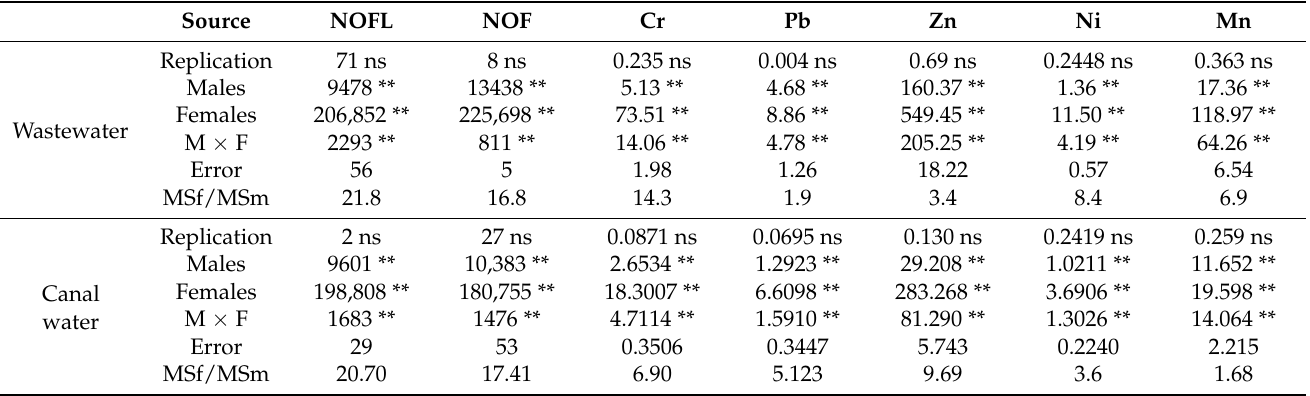
Table 1. Analysis of variance for attributes related to yield and HM accumulation in tomato fruit irrigated with wastewater and canal water (North Carolina matting